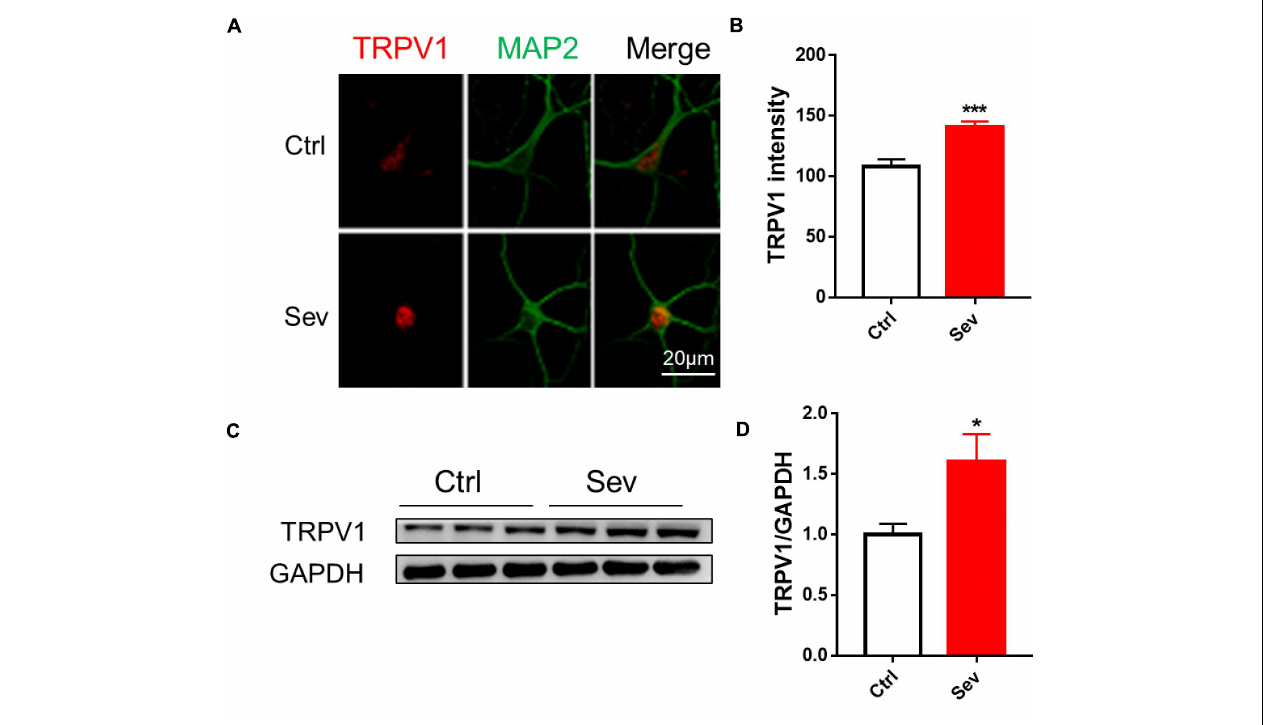
FIGURE 1 | Sevoflurane increased protein levels of TRPV1 channels in vivo and in vitro . (A) Fluorescent images of TRPV1 in hippocampal neurons (B) Quantitative analyzed the optical density of TRPV1 protein signal [3 cultures per group, unpaired t -test, t ( 22 ) = 4.6, p < 0.001]. (C) Anesthesia with 3% sevoflurane 2 h daily for 3 days at P7 increased the expression of TRPV1 in the hippocampus of mice harvested at P9 (D) Quantification of the Western blot shows that sevoflurane anesthesia increased the protein levels of TRPV1 compared to that observed under the control conditions [ n = 6, unpaired t -test, t ( 10 ) = 2.5, p = 0.0343]. Data are presented as the mean ± SEM. * p < 0.05; *** p < 0.001. Ctrl, control; Sev,